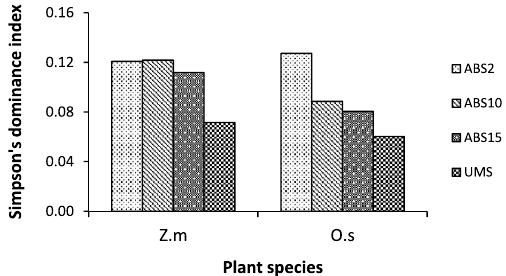
Fig. 4. Simpson dominance index in trap culture set up with study sites derived inocula where Zea mays L. (Z.m) and Oryza sativa L. (O.s) are used as trap plants.